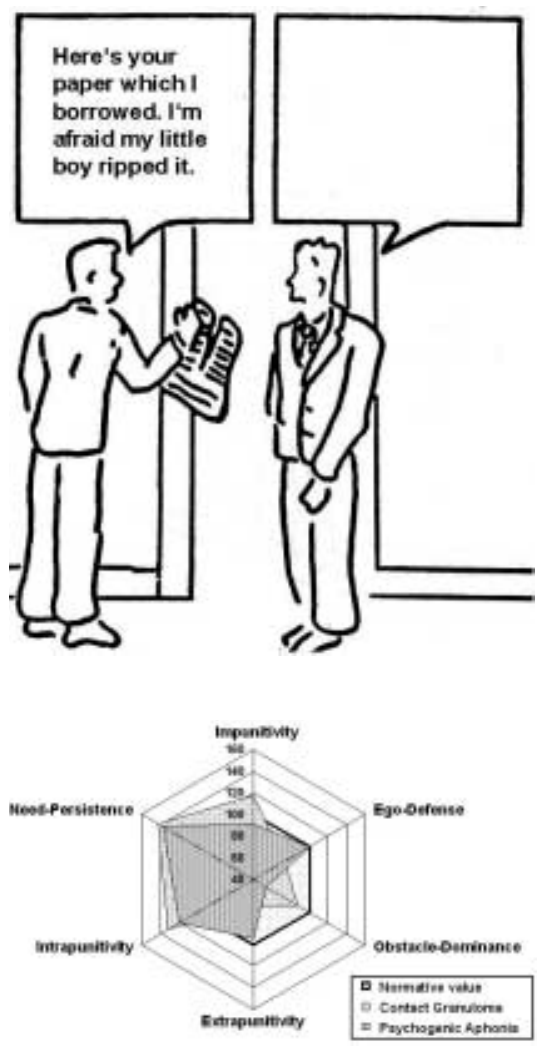
Example of a cartoon situation from the PFT. The patient has to answer for the per- son experiencing the frustation (printed with kind permission of the Hogrefe-Ver- lag, Goettingen).